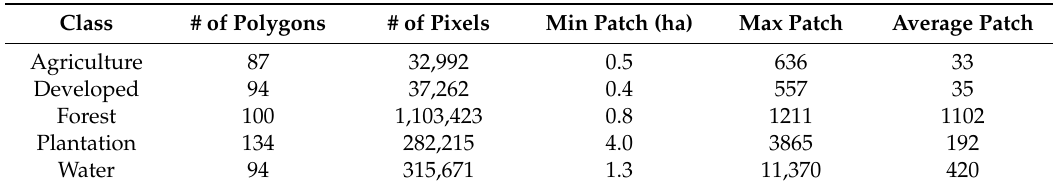
Table 1. Training data characteristics across both study